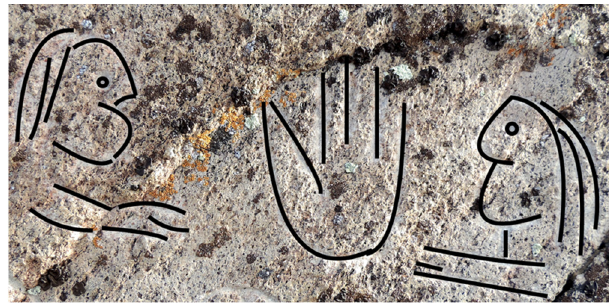
Figure 32. Tonopah, NV detail, “You”—did so—“You”. (Digital tracing).